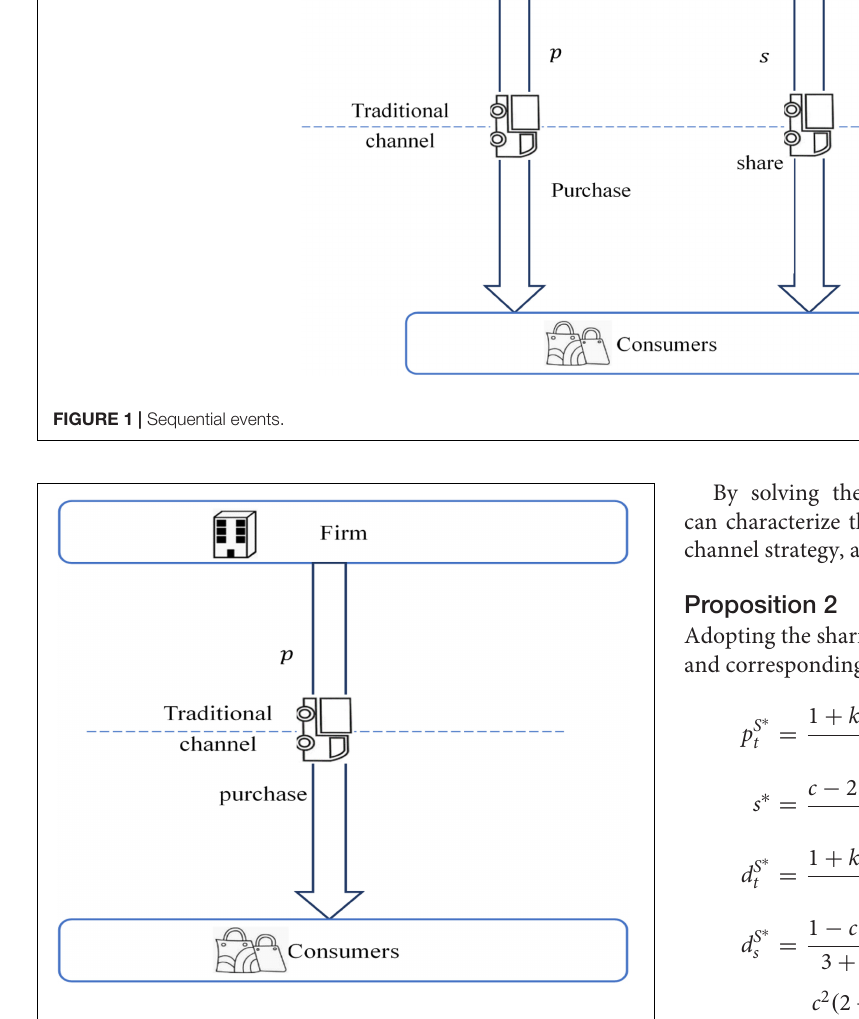
FIGURE 2 | The sequential events of the benchmark